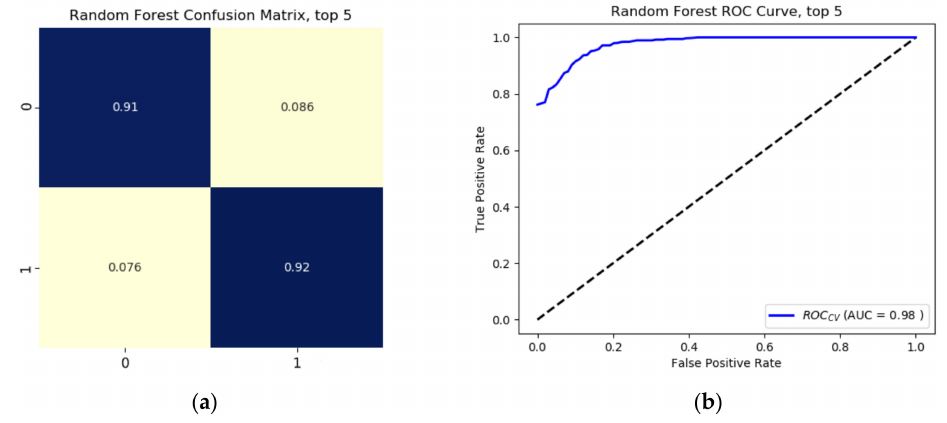
Figure 10. The pod formation binary classification for the [CR-spec] data set: ( a ) confusion matrix (class 0 = non-pod formation, class 1 = pod formation), ( b ) ROC